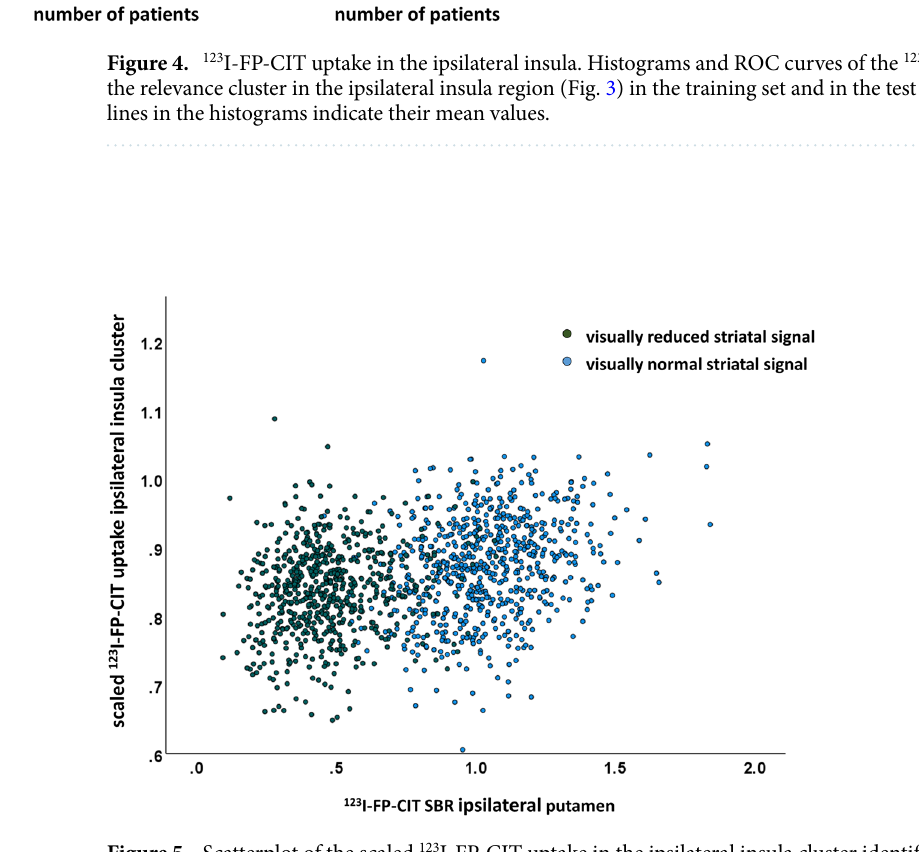
Figure 5. Scatterplot of the scaled 123 I-FP-CIT uptake in the ipsilateral insula cluster identified by LRP in the “without striatum” setting (Fig. 3) versus the specific binding ratio (SBR) of 123 I-FP-CIT in the ipsilateral putamen in the whole sample (n = 1306). The color of the symbols indicates PD-typical reduction of (green) or normal (blue) striatal 123 I-FP-CIT uptake according visual